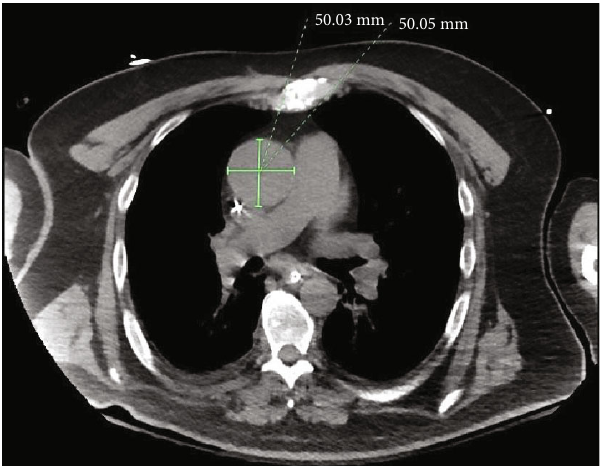
Figure 2: Soft-tissue axial view of CT chest demonstrating dilated aortic root.